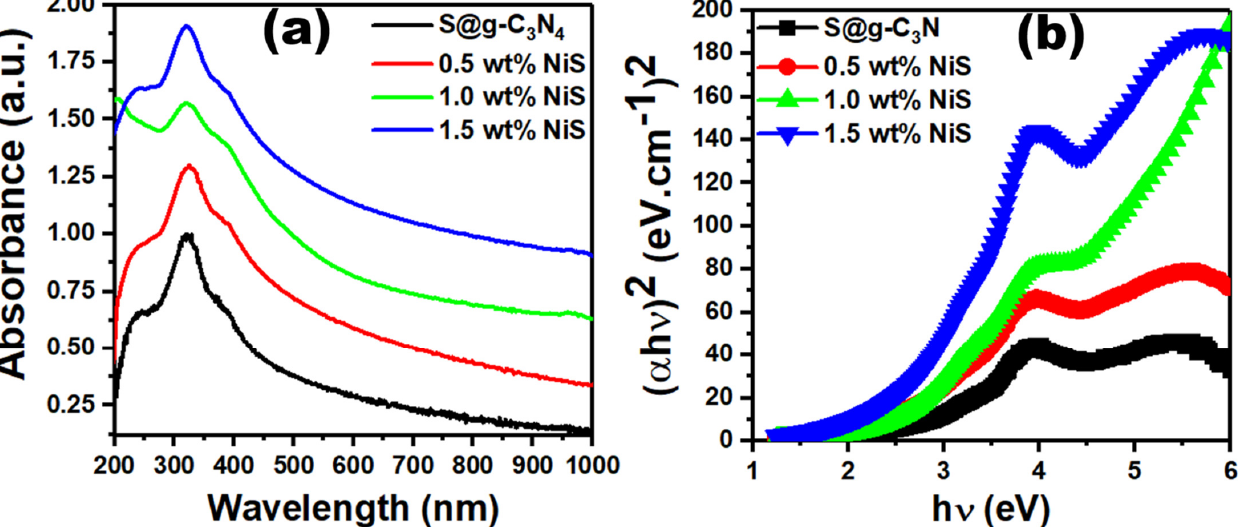
Figure 5. Nitrogen adsorption–desorption isotherm of S@g-C 3 N 4 and NiS-g-C 3 N 4 nanocomposites. The absorbance properties of S@g-C 3 N 4 and NiS-g-C 3 N 4 nanocomposite samples